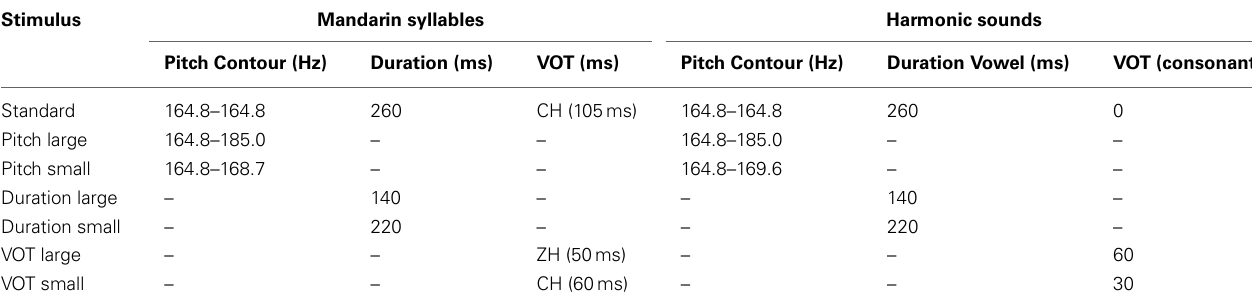
Table 2 | Summary of the acoustic properties of auditory